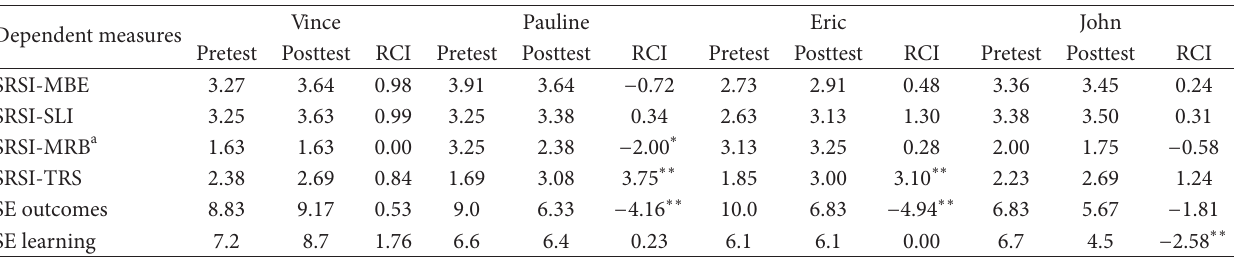
T 4: Reliability change index (RCI) scores across self-regulation and motivation